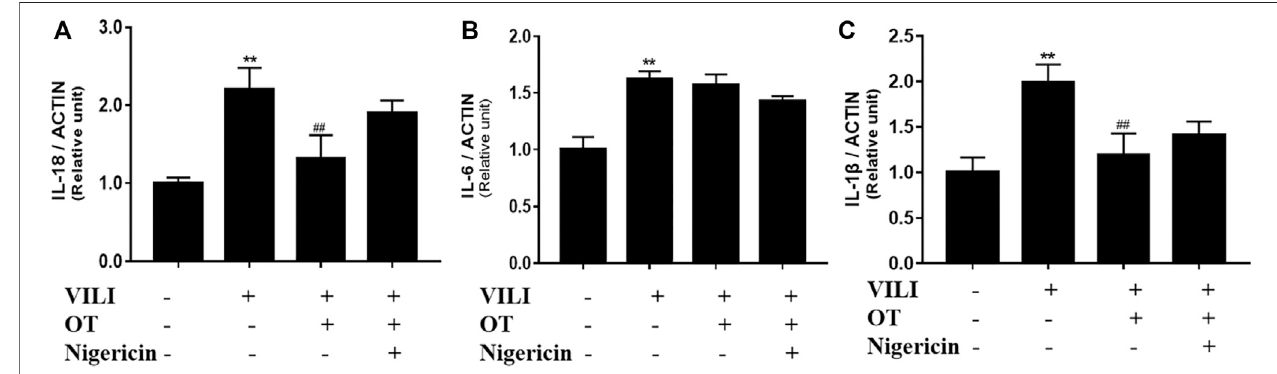
FIGURE 10| Effects of oxytocin on cytokine concentrations of IL-18, IL-6, and IL-1 β in the BALF from VILI mice treated with or without Nigericin.The expression of the IL-1 β (A) , IL-6 (B) , and IL-18 (C) in the BALF from mice VILI model. The data are presented as the means ± SD ( n (cid:2) 5). * p < 0.05, and ** p < 0.01 compared with the Control group; # p < 0.05 and ## p < 0.01 compared with the VILI group. OT, oxytocin; SD, standard deviation; VILI, ventilation-induced lung